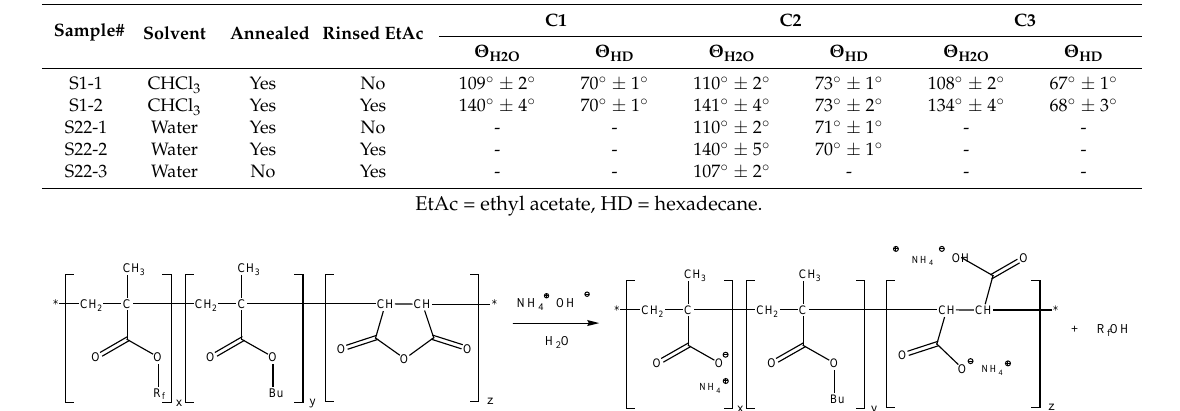
Table 6. Surface properties of the coatings on glass, before and after washing with ethyl acetate.